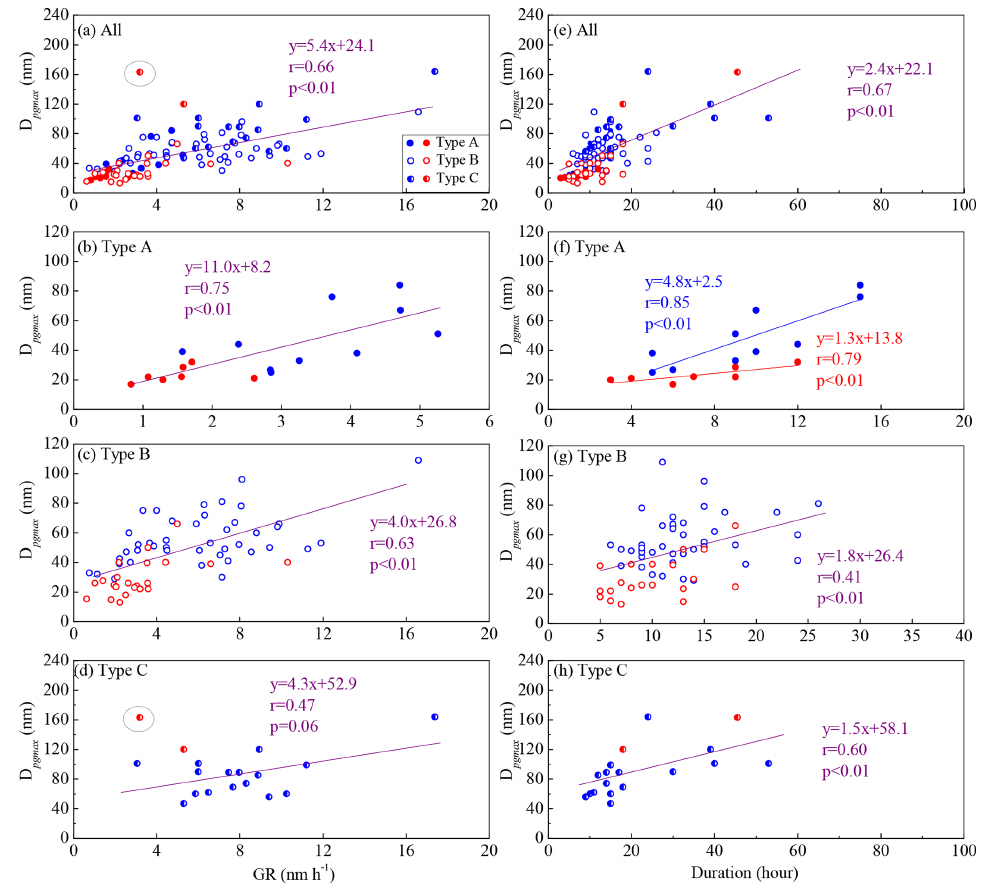
Figure 7. Relationship between the GR and D pgmax (a–d) and between the duration of NPF events and D pgmax (e–h) . Solid markers represent Type A, empty markers represent Type B, and half-solid markers represent Type C. Red markers and equations represent 2017 and 2018, and blue markers and equations represent 2007–2015. The purple equation represents fitting of all data, and the circled marker represents an outlier from the equation